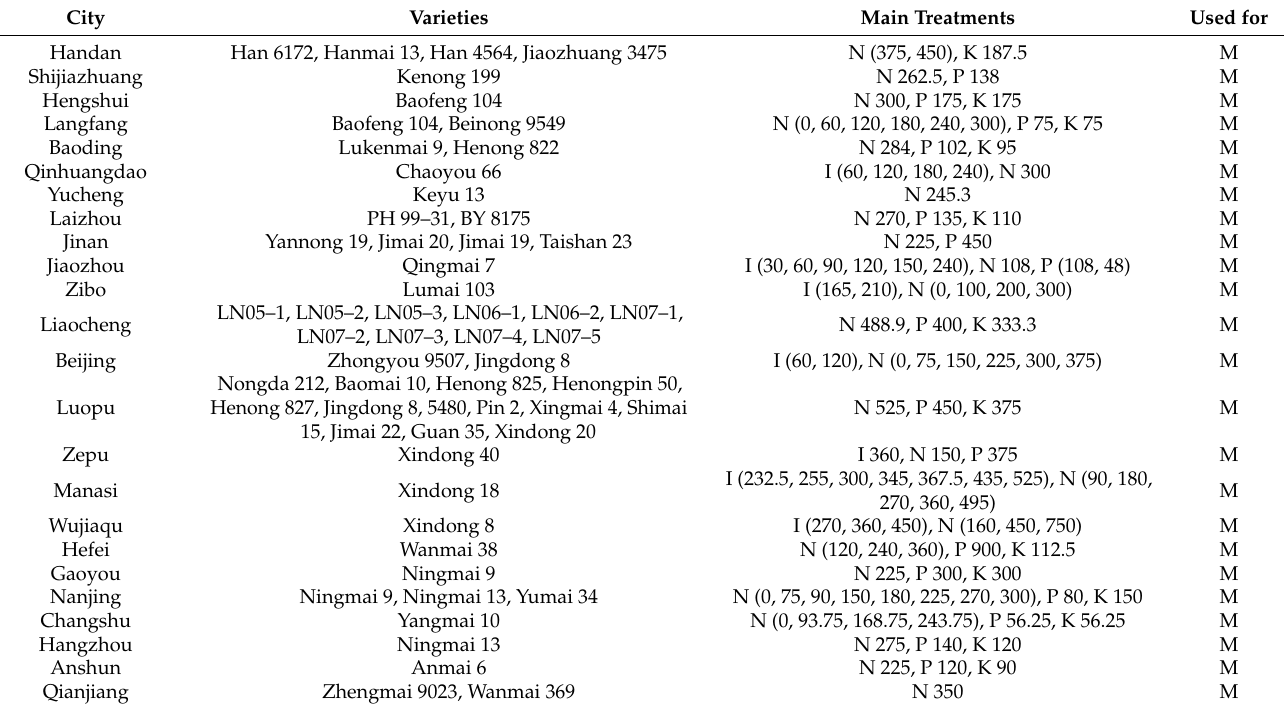
Table 2. Varieties and Main Treatments at Each Site of Winter Wheat in China. N, N fertilisation V,